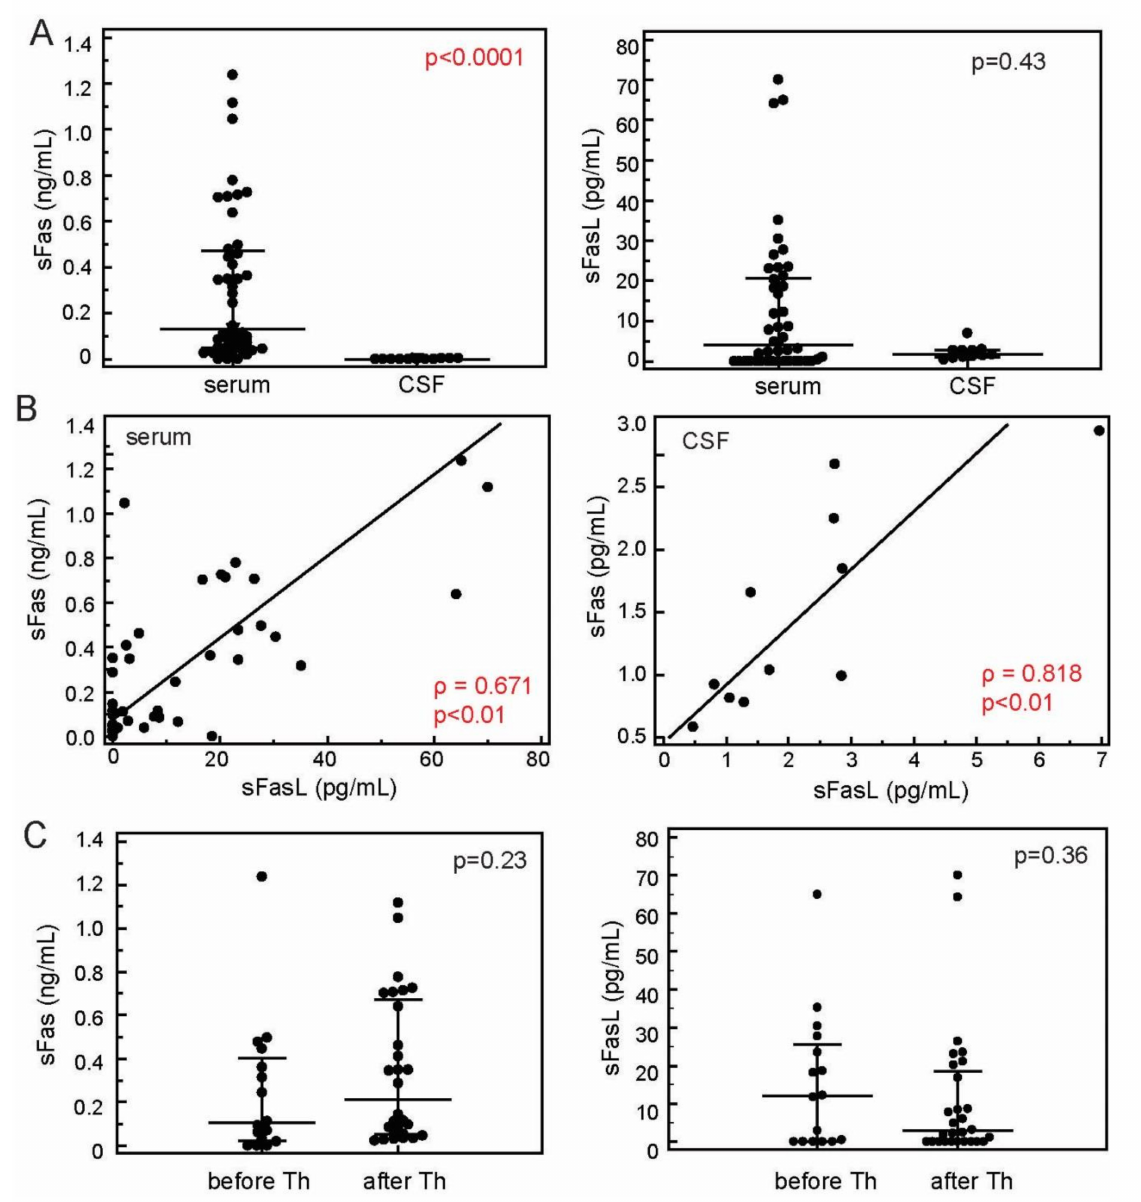
Figure 2. Concentrations of the sFas and sFasL in the sera ( N = 44) and cerebrospinal (CSF) fluid ( N = 11) of patients with RRMS ( A ). Association of concentrations of the sFas and sFasL in the sera ( N = 44) and CSF ( N = 11) of patients with RRMS ( B ). Concentrations of the sFas and sFasL in the sera of patients with RRMS before the initiation of corticosteroid therapy (before Th, N = 16) and within 24 h after initiation of therapy (after Th, N = 28) ( C ). Concentrations of sFas and sFasL were measured using cytometric bead-based arrays (LEGENDplex, Biolegend). Markers, individual patients’ values, horizontal lines and bars, median ± IQR; p values, Mann-Whitney U-test ( A , C ), Spearman’s rank correlation ( B ), ρ , correlation coe ffi